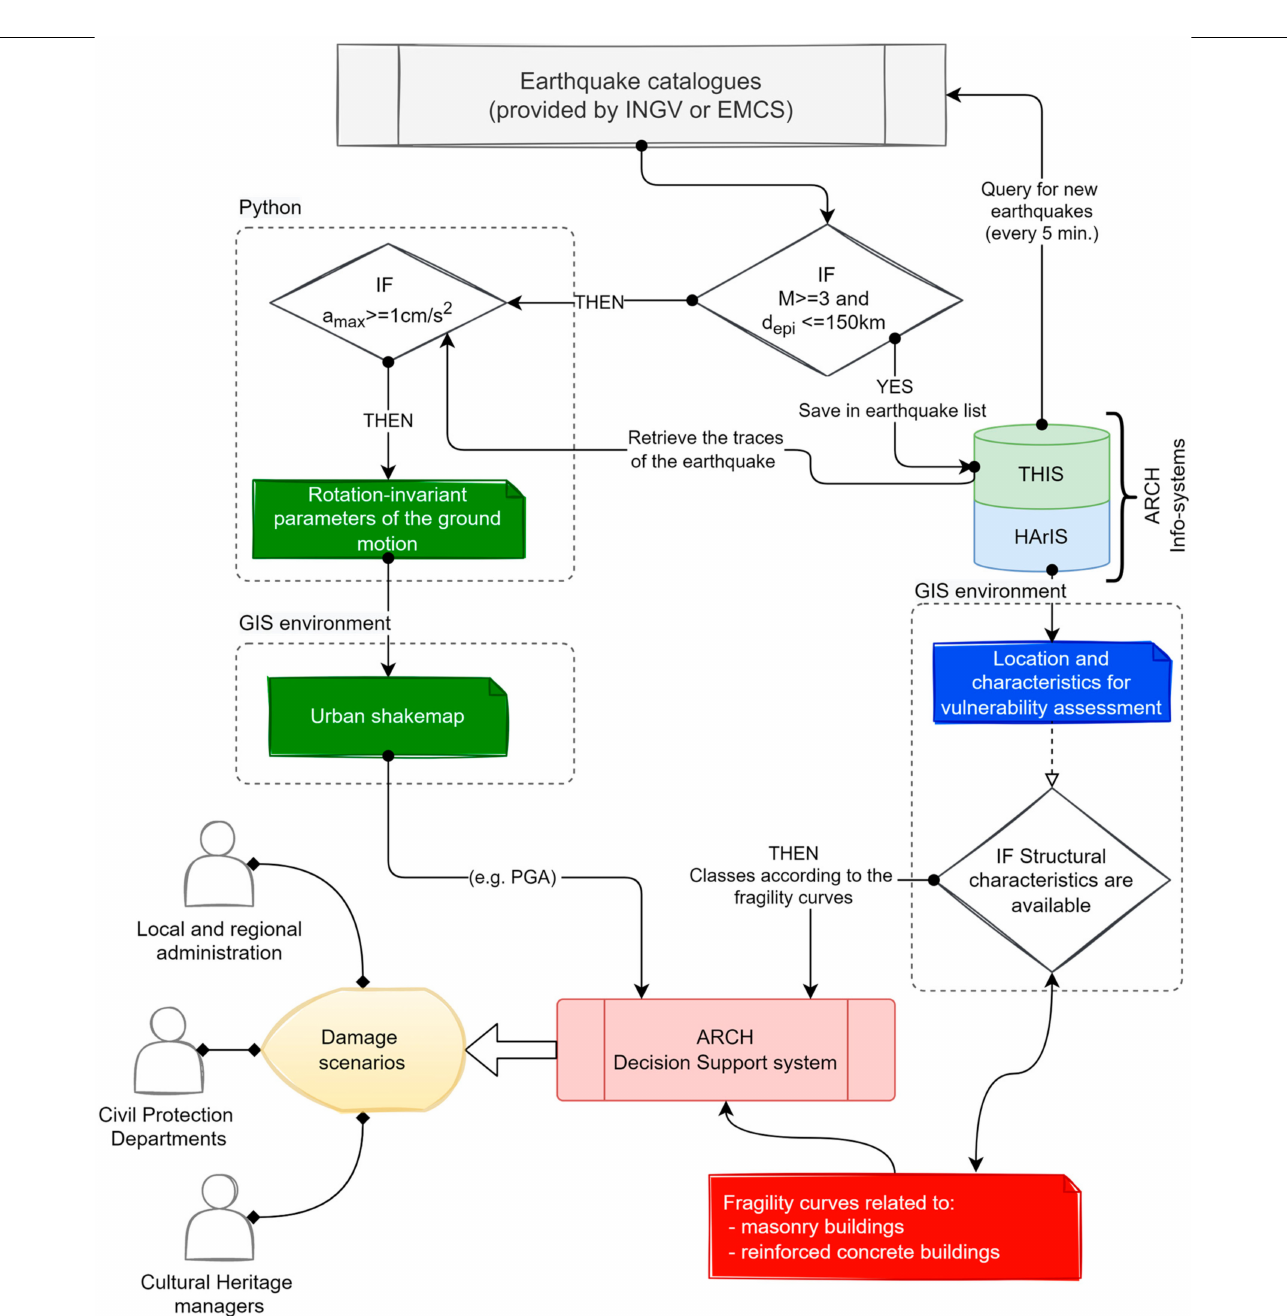
Figure 4. Structure of the interaction between systems and components: from the detection of a new earthquake to the definition of the potential damage